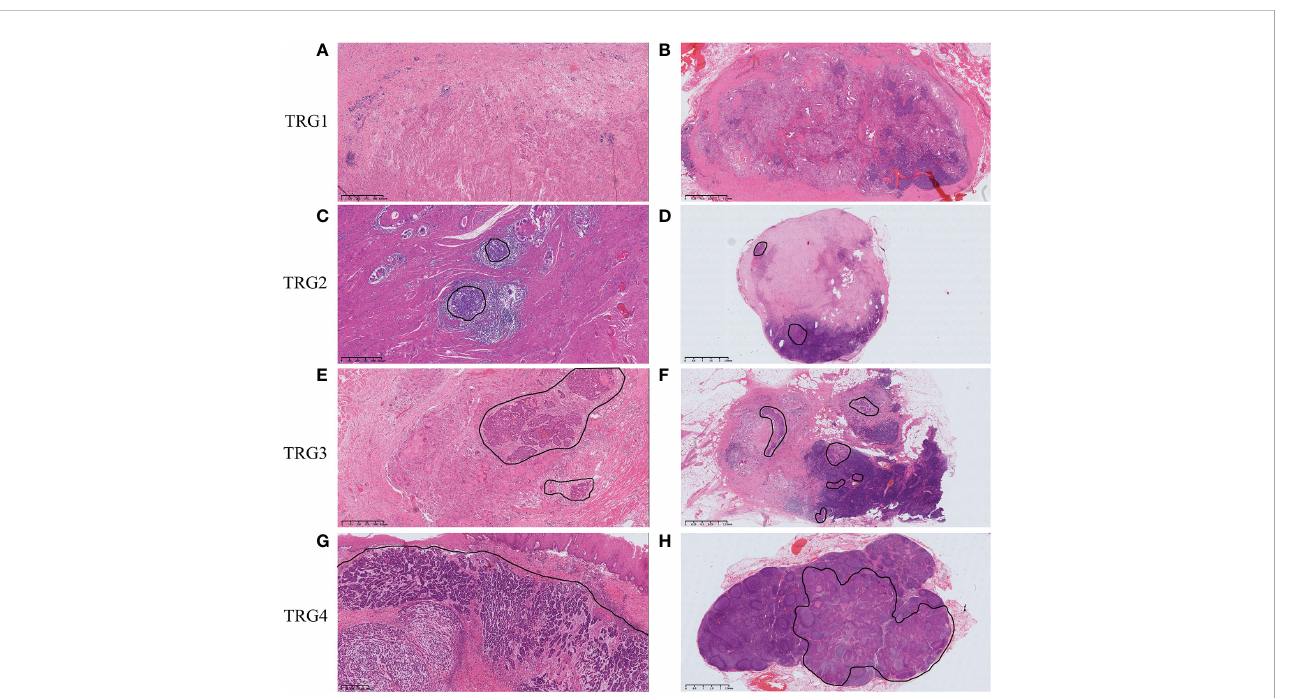
FIGURE 1 Tumor regression grading according to Chirieac et al. in ESCC. (A) TRG1 in esophageal wall, no residual carcinoma in esophageal wall. (B) TRG1 in lymph nodes, no residual carcinoma in resected lymph nodes. (C) TRG2 in esophageal wall, 1% to 10% residual carcinoma in esophageal wall. (D) TRG2 in lymph nodes, 1% to 10% residual carcinoma in resected lymph nodes. (E) TRG3 in esophageal wall, 11% to 50% residual carcinoma in esophageal wall. (F) TRG3 in lymph nodes, 11% to 50% residual carcinoma in resected lymph nodes. (G) TRG4 in esophageal wall, greater than 50% residual carcinoma in esophageal wall. (H) TRG4 in lymph nodes, greater than 50% residual carcinoma in resected lymph